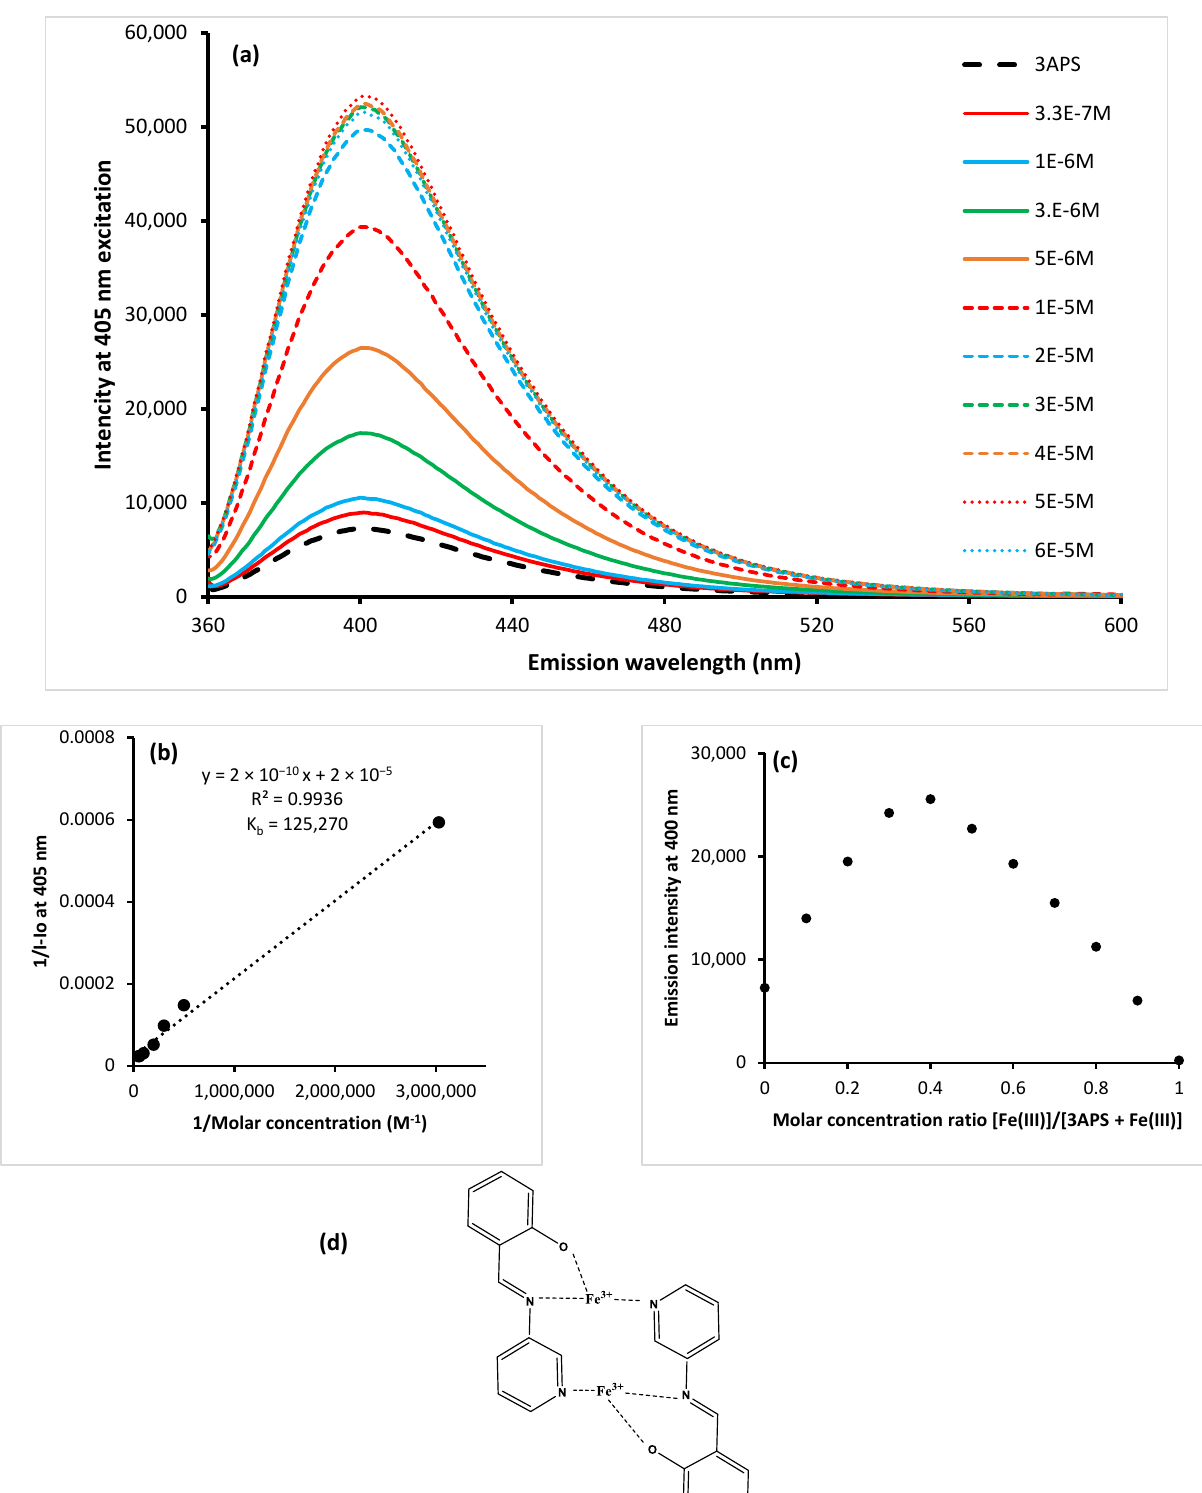
Figure 11. Fluorescence titration spectra of 3APS (2 × 10 − 6 M) with Fe(III) (3.3 × 10 − 7 – 6 × 10 − 5 ) in ACN – water (1:9) at 405 nm ( a ). In the Benesi – Hildebrand plots for the titration of 3APS with Fe(III) at 405 nm, A 0 is the absorbance of 3APS in the absence of Fe(III), A is the absorbance of the 3APS – Fe(III) complex in ACN – water (1:9) ( b ). Job’s plot of 3APS with Fe(III) at 405 nm ( c ).The predicted structure of the 3APS – Fe(III) complex ( d ).